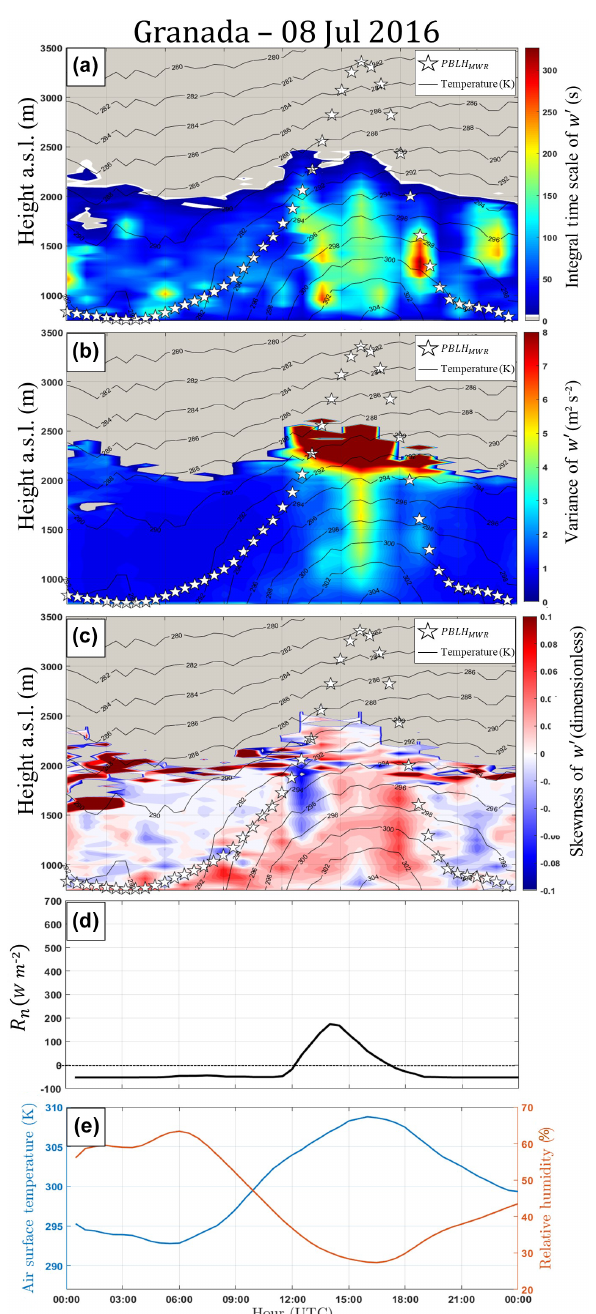
Figure 14. (a) Integral timescale from Doppler lidar data ( τ w (cid:48) ), (b) variance from Doppler lidar data ( σ 2 ), (c) skewness from w (cid:48) Doppler lidar data ( S w (cid:48) ), (d) net radiation from pyranometer data ( R n ), and (e) air surface temperature (blue line) and surface relative humidity (RH – orange line) from surface sensor data. All profiles were obtained in Granada on 8 July 2016. In (a) , (b) and (c) , black lines and white stars represent air temperature and PBLH MWR , re- spectively.